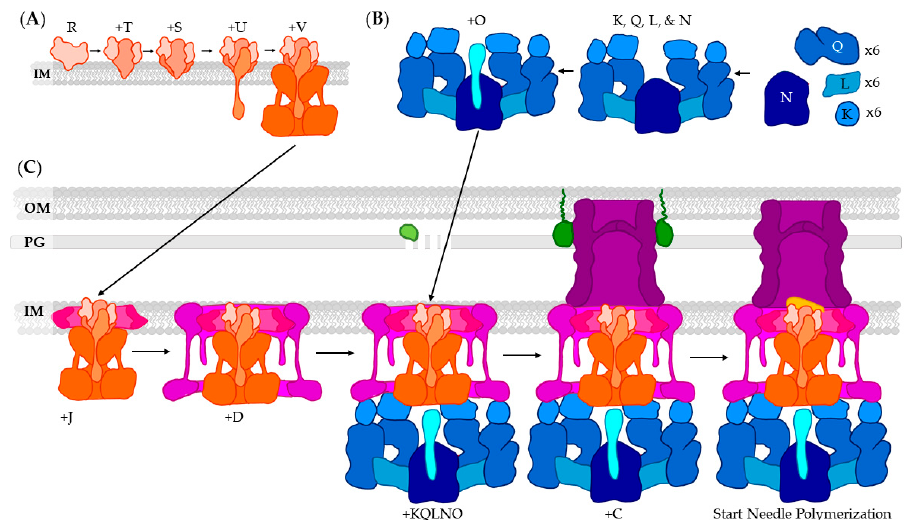
Figure 10. Assembly of the injectisome base. Protein names are abbreviated by their conserved name while omitting “Sct” from the beginning. ( A ) Independent formation of the export apparatus within the bacterial IM; ( B ) Formation of the cytoplasmic complex; ( C ) Basal body formation around the export apparatus and connection of cytoplasmic complex. Image modified from [163]. Abbreviations: OM, outer membrane; PG, peptidoglycan; IM, inner membrane.